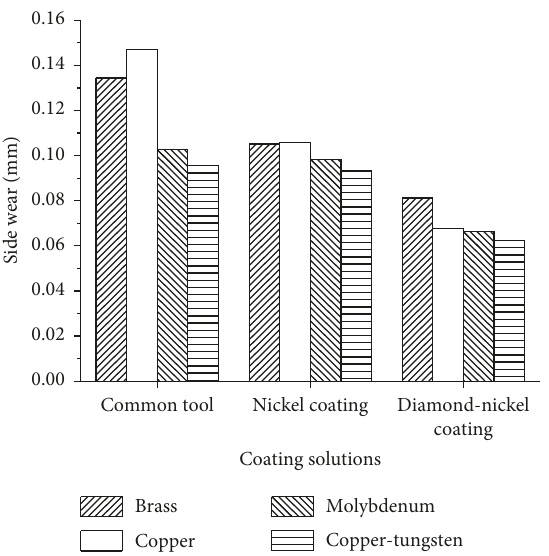
Figure 10: Side wear of different coated tools.